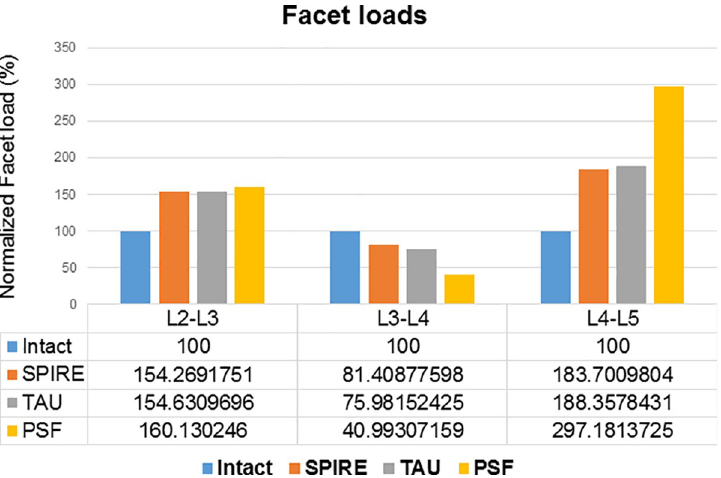
Fig 5. Facet loads during extension at surgical and adjacent levels in implanted lumbar models (Data were normalized with respect to the intact model as percentage values).